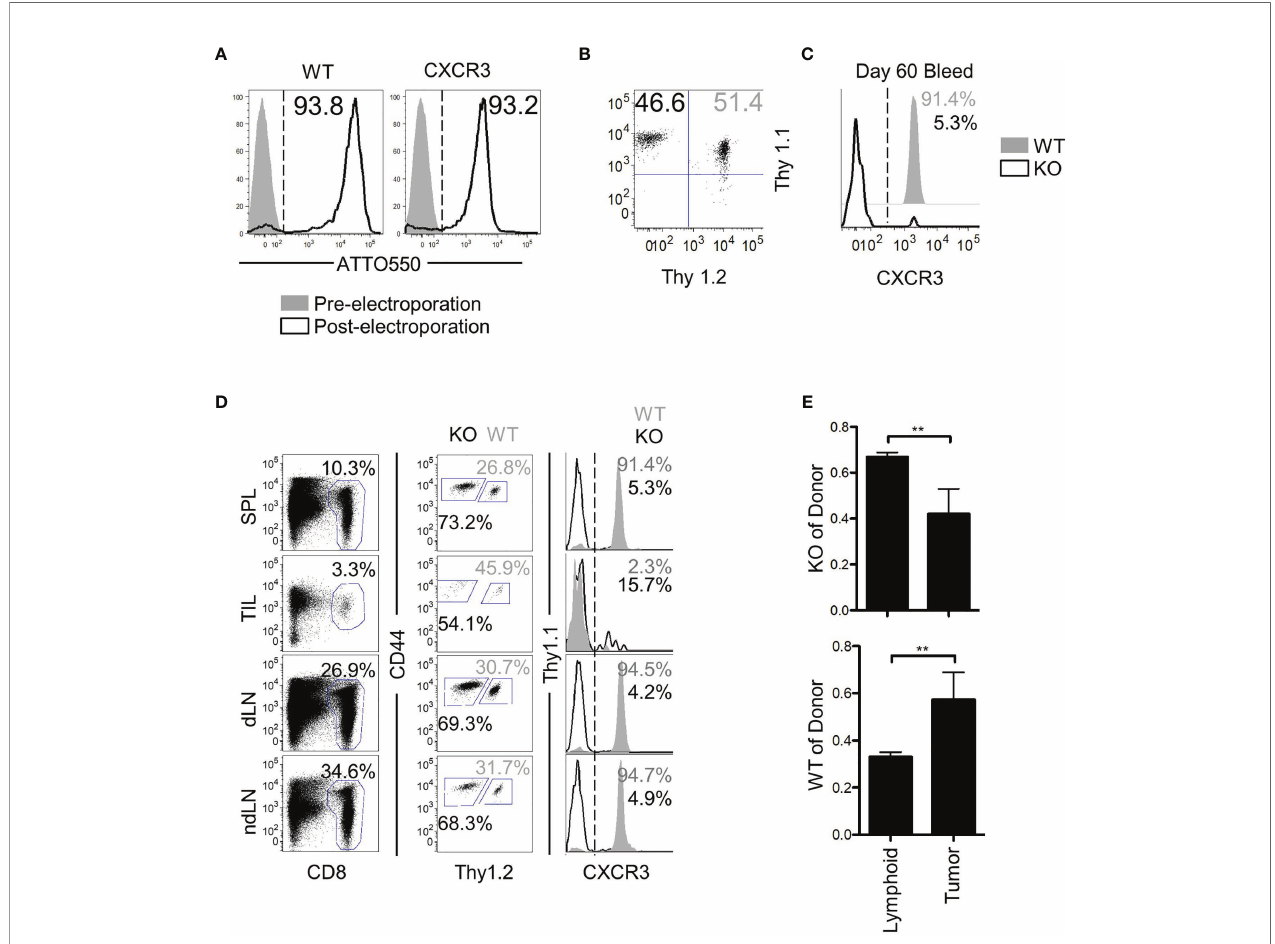
FIGURE 5 | CXCR3 is necessary for proper localization of bystander memory to the tumor. (A) Histograms of CD8 T cells pre- and post-Neon electroporation to show percent of cells that acquired ATTO550-labeled CRISPR-Cas9 RNP complex. Percent WT of donor is shown in solid grey, KO in black. (B) Cells were mixed 1:1 before adoptive transfer into B6 mice. (C) Con fi rmation of loss of CXCR3 protein in the knockout population at memory. (D) Representative plots of total CD8 and of donor populations in each tissue collected. Percent of CD8 is shown above the CD8 gate. Percent of cxcr3 WT (gray) and KO (black) out of total donor CD8 cells is shown adjacent to each gate (middle column). Con fi rmation of cxcr3 KO in each tissue is shown by histogram for CXCR3 expression. Percent WT of donor is shown in solid grey, KO in black. (E) Bar graphs showing the proportion of cxcr3 KO (top) or WT (bottom) CD8 T cells to total donor cells present in either lymphoid tissues (Spleen and Lymph Nodes combined) or in tumors. **p < 0.01 as determined by paired T-test. Representative plots are shown from N=5 mice per group. Data is representative of 2 independent